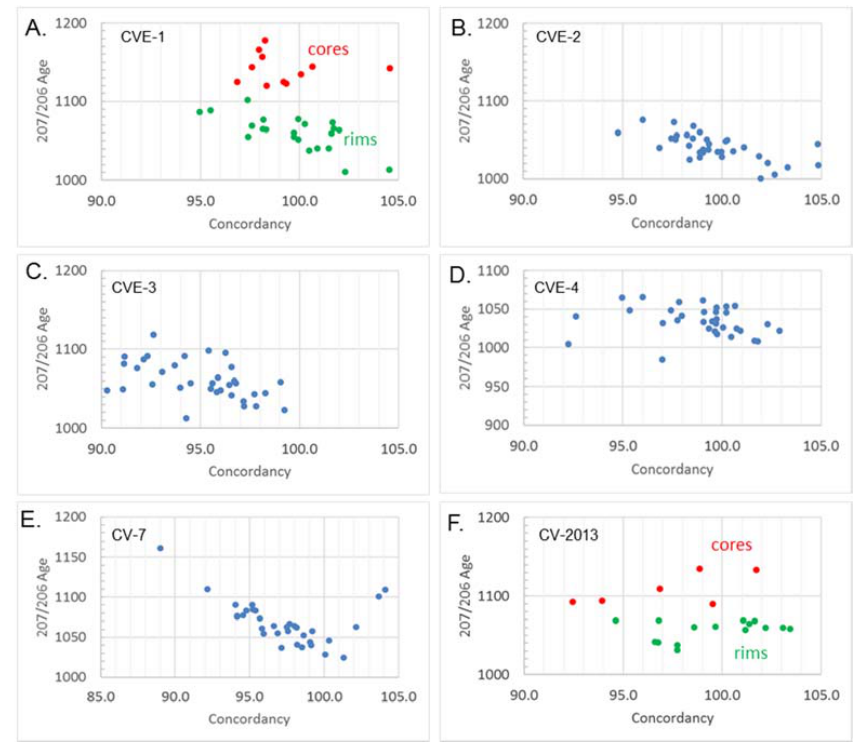
Figure 9. Scatter plots showing the variation of concordancy with the 207 Pb/ 206 Pb age for each analysis for samples: ( A ) CVE-1, ( B ) CVE-2, ( C ) CVE-3, ( D ) CVE-4, ( E ) CV-7, and ( F ) CV-2013. Blue dots represent samples with homogeneous zircon populations lacking core-rim relationships.